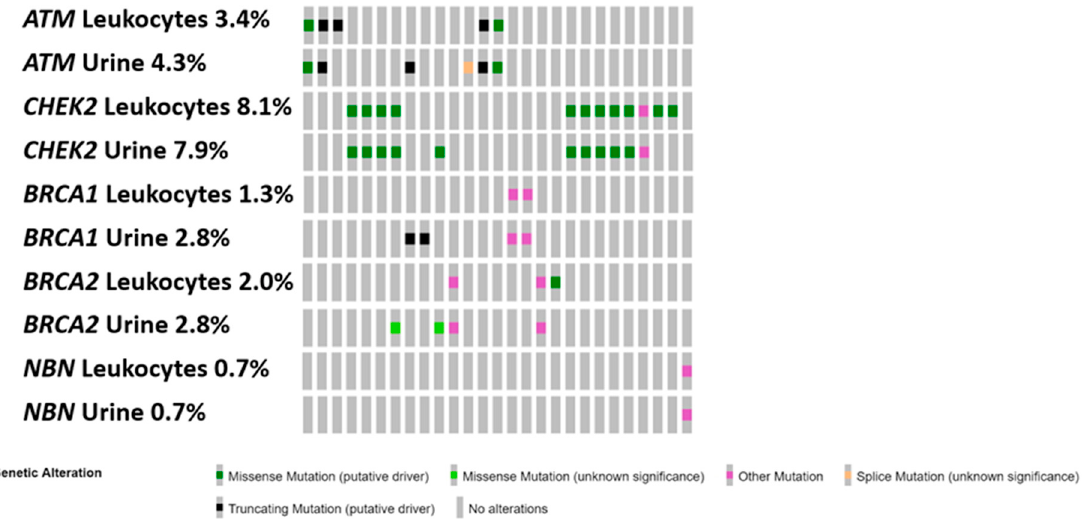
Figure 1. Oncoprint of selected pathogenic alterations detected in urine and leukocyte samples. Only samples with at least one detected mutation are shown. The percentages correlate to the number of mutations found in all 149 patients analysed in leukocytes and 139 in urine samples.